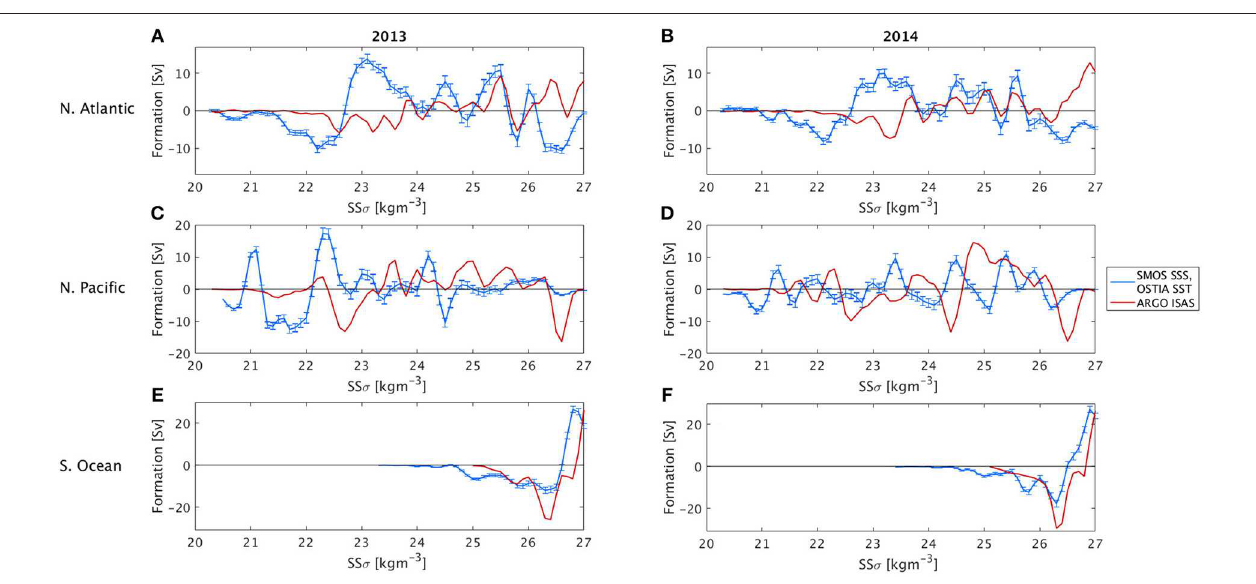
FIGURE 10 | Annually averaged formation with error bars in σ -space for the year 2013 (left column) and 2014 (right column) over the North Atlantic (A,B) , North Pacific (C,D) , and Southern Ocean (E,F) . The blue and red lines indicate formation in σ -space calculated using SMOS-OSTIA and Argo ISAS SSS and SST, respectively. Error bars indicate uncertainty over 500 Monte-Carlo